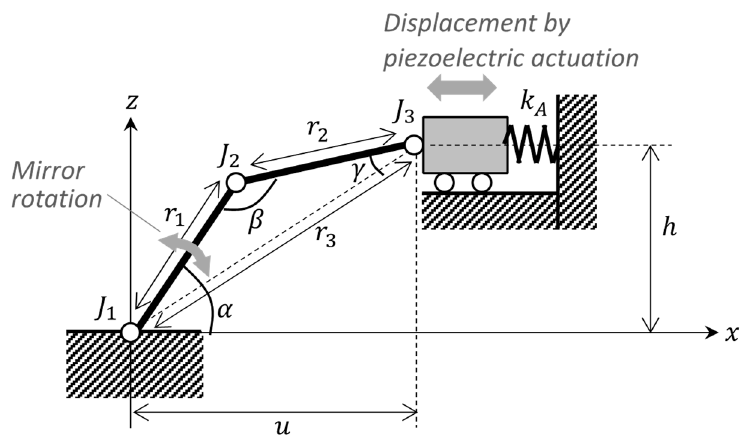
Figure 6. Simplified theoretical model to estimate static actuation angle.